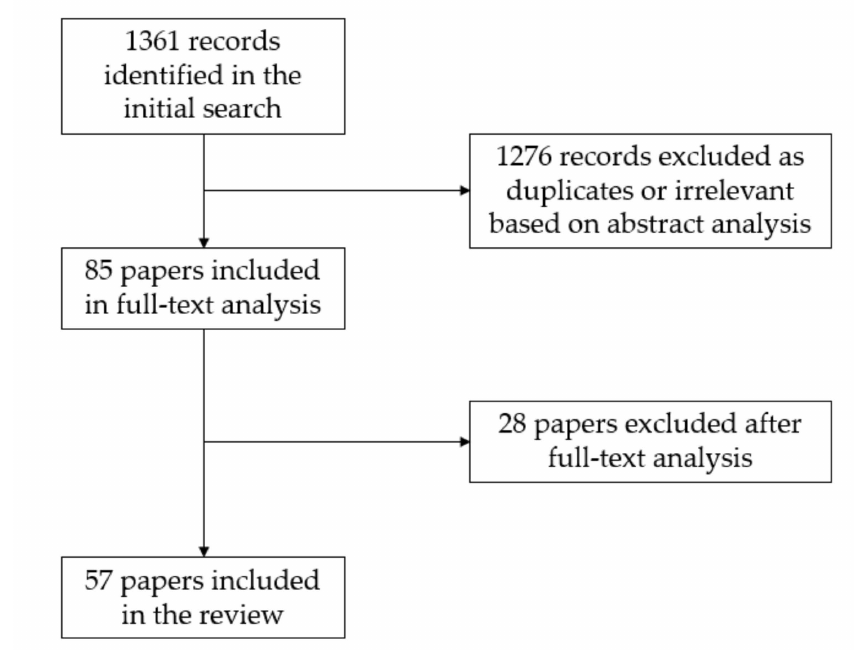
Figure 3. Search and study selection